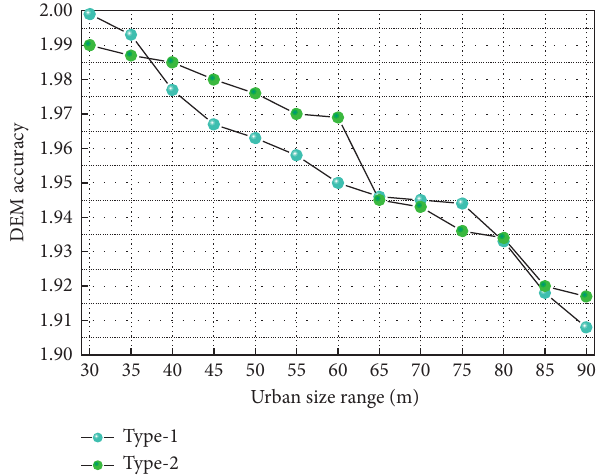
Figure 1: Variation of box dimension with DEM accuracy at each scale. Type 1 is DEM data for resampling and type 2 is sampled data for box size calculation.